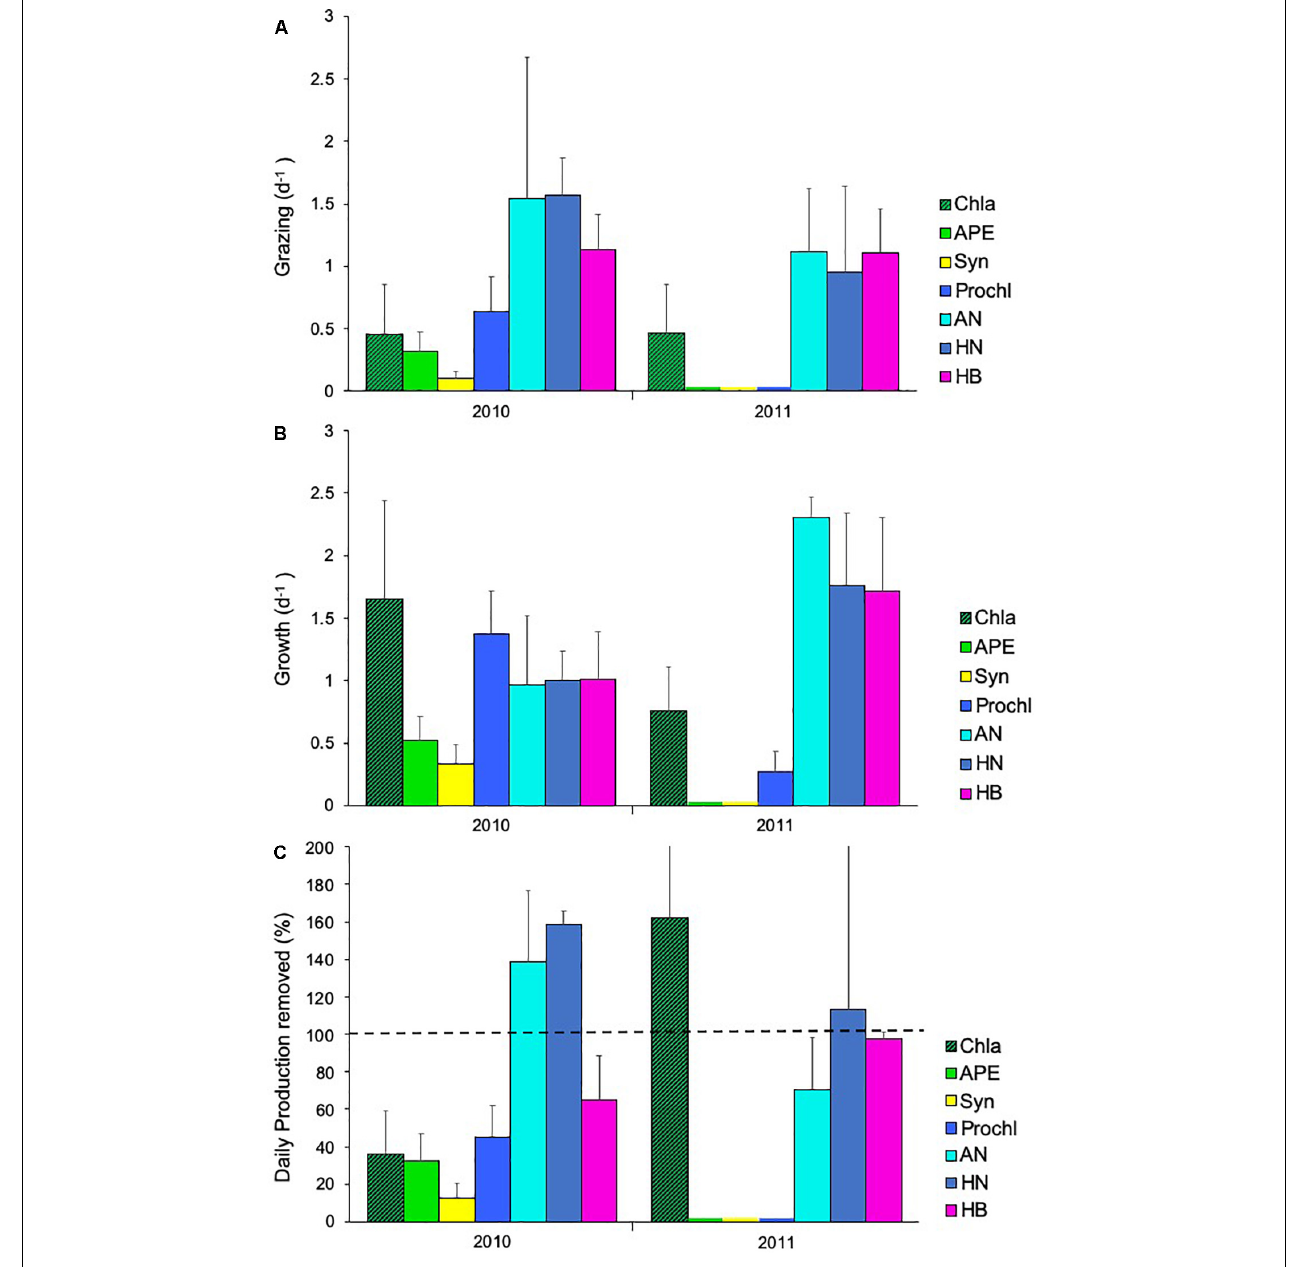
FIGURE 10 | Rates of (A) growth (d − 1 ), (B) grazing (d − 1 ), and (C) daily production removed (%) ( ± SE) in 2010 and 2011 for chlorophyll a (Chl a , (cid:4) ), autotrophic picoeukaryotes (APE, (cid:4) ), Synechococcus (Syn, (cid:4) ), Prochlorococcus (Prochl, (cid:4) ), autotrophic nanoflagellates (AN, (cid:4) ), heterotrophic nanoflagellates (HN, (cid:4) ) and heterotrophic bacteria